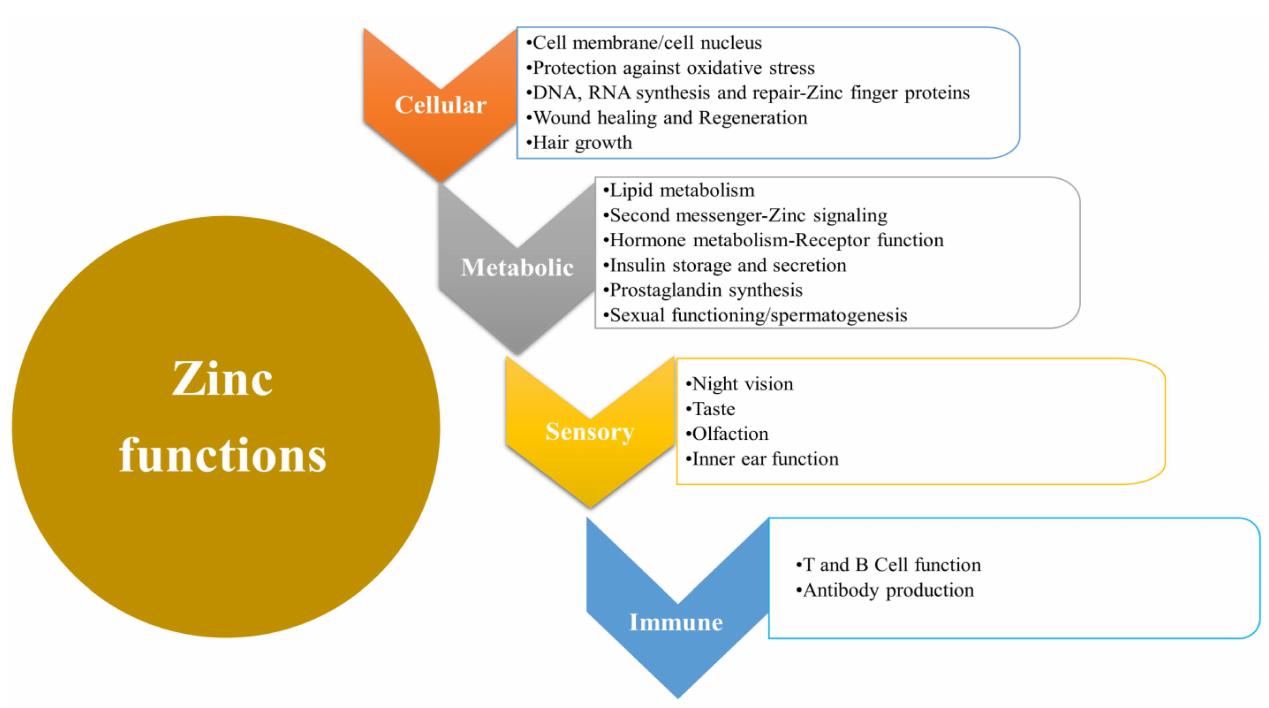
Figure 2. Biological functions of Zinc in the human